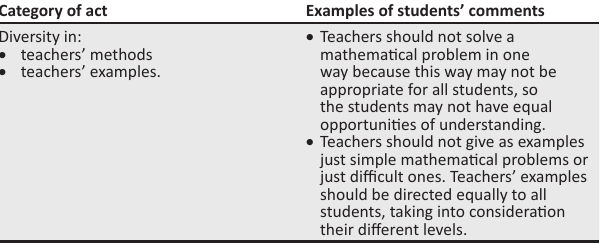
TABLE 8 : Didactic acts promoting inequality. Category of act Examples of students’ comments